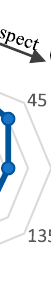
Figure 10. Relationship between vegetation damage and slope orientation.